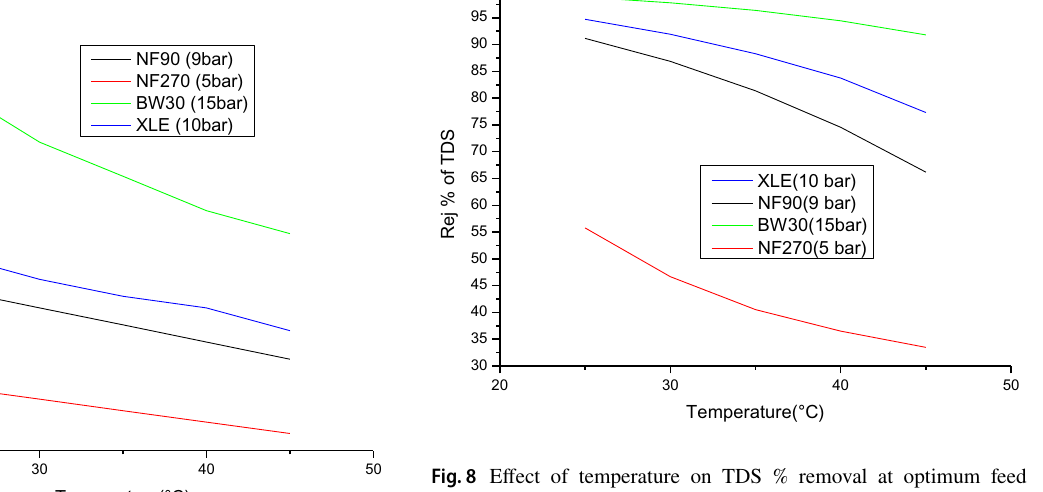
Fig. 8 Effect of temperature on TDS % removal at optimum feed pressure for conf a